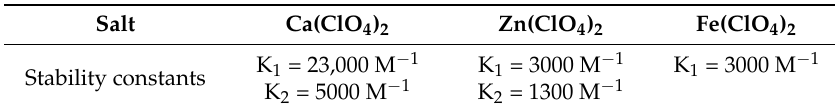
Scheme 1. Complexation of astaxanthin with divalent metal ions. Table 1. Stability constants of astaxanthin chelate complexes with divalent metal ions in ethanol solution, adopted from reference [12].